Question: What style of plot is this figure drawn as?
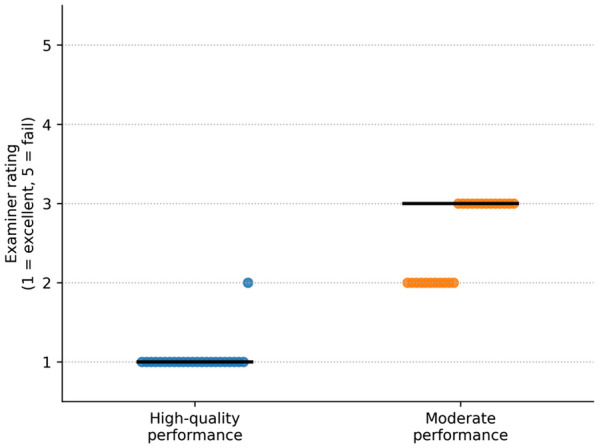
Answer: scatter